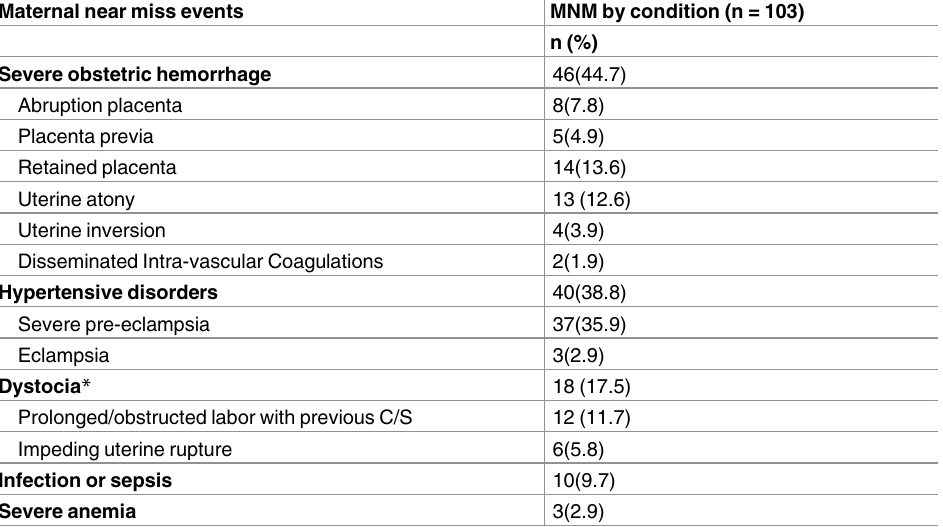
Table 4. Clinical characteristics of maternal near misses of mothers admitted in public hospitals, Tigray, Northern Ethiopia, 2016. (N =